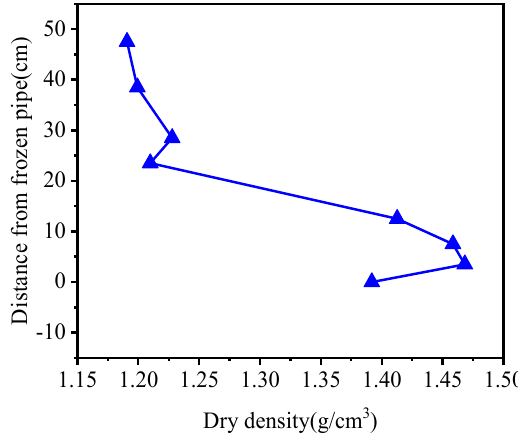
Figure 10. Change of water content.